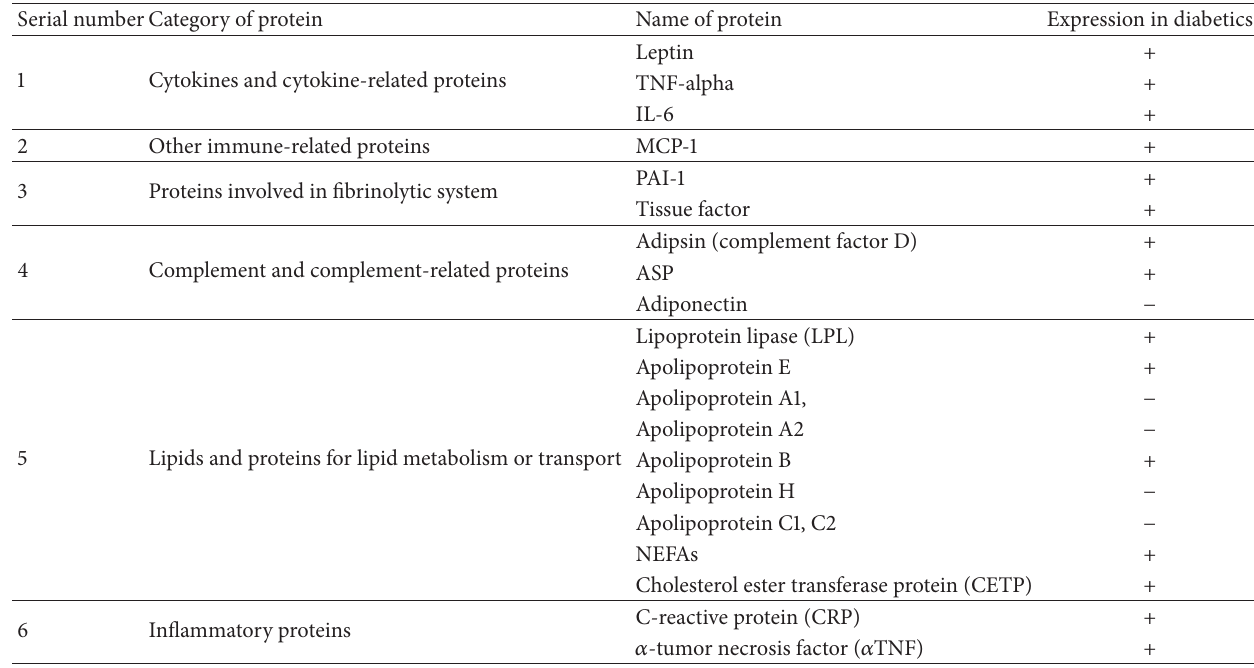
Table 1: Serum proteins identified in diabetes